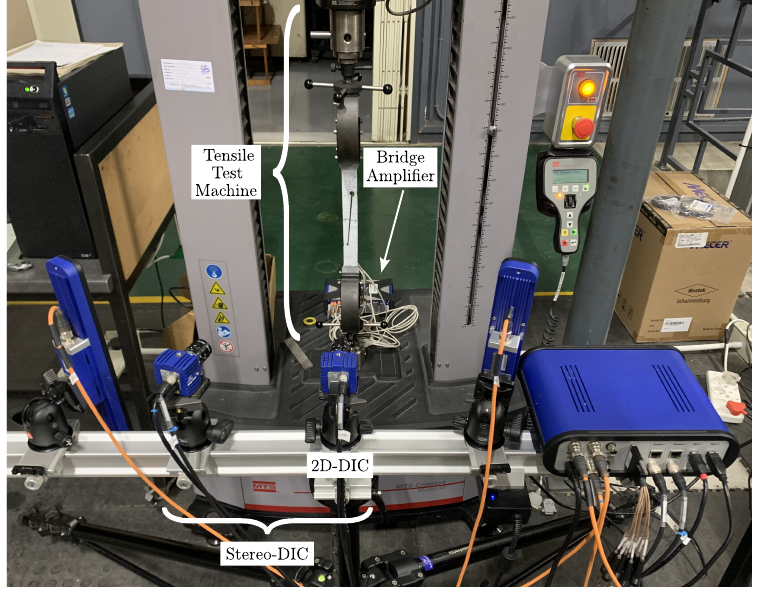
Figure 3. Test setup used for the experimental verification of the strain-gauge-based error compensa- tion